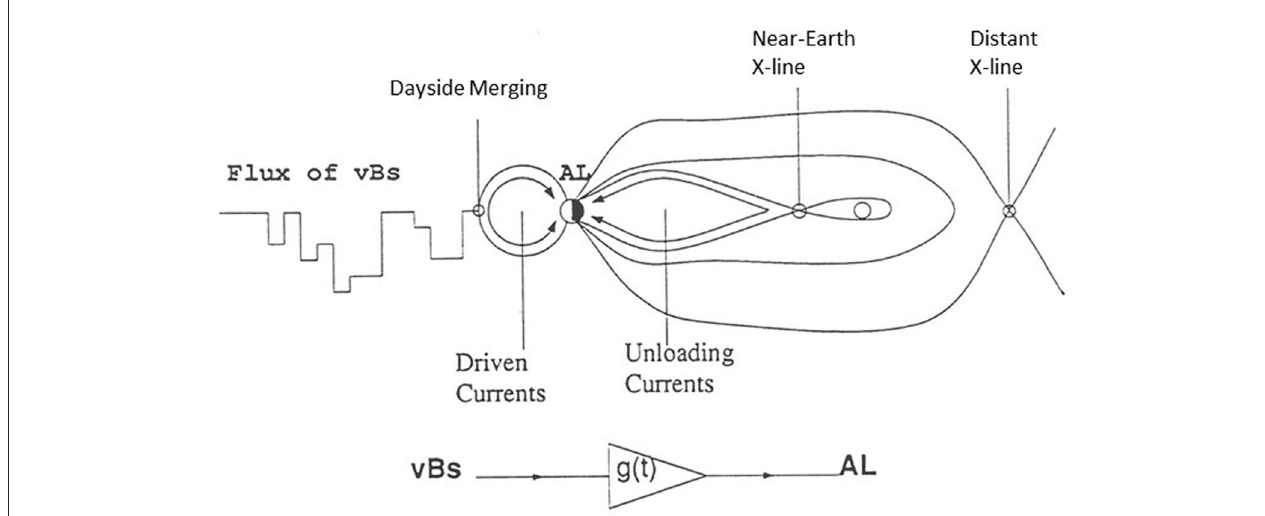
FIGURE 6 | The response of the magnetosphere to the solar wind IMF. In this diagram, the global configuration and magnetic topology are shown and currents are illustrated. The magnetosphere is treated as a linear filter relating VB S to AL (adapted from Blanchard and McPherron, 1992).